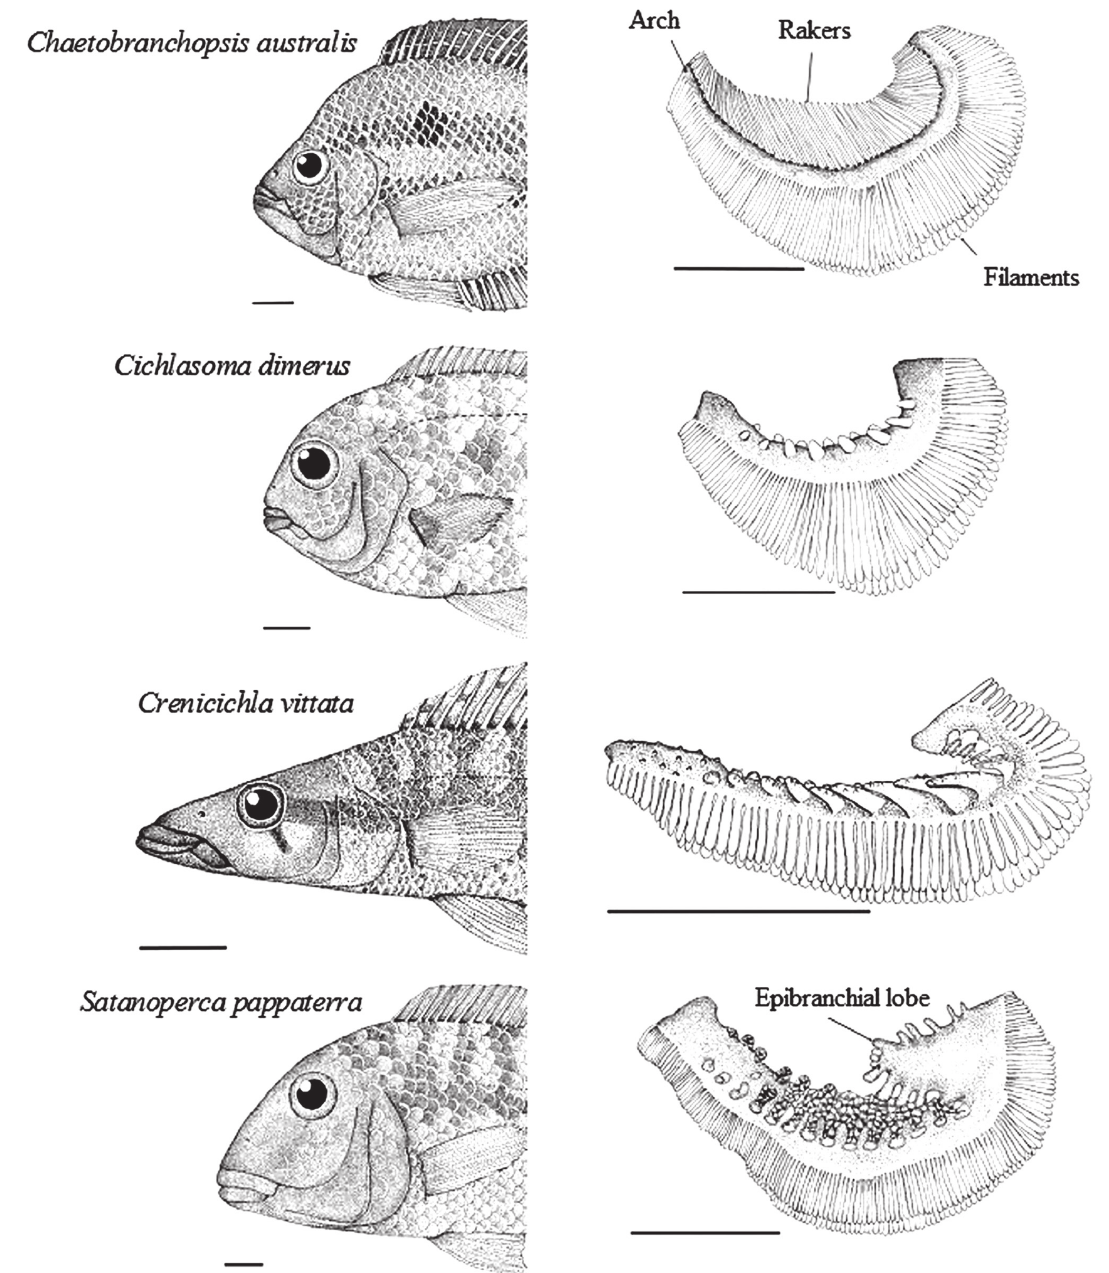
Fig. 4. Position and shape of the mouth, and first pair of gill raker of cichlids from the Cuiabá River basin, Mato Grosso, Brazil. Scale = 1 cm. (drawing by Gisele C.